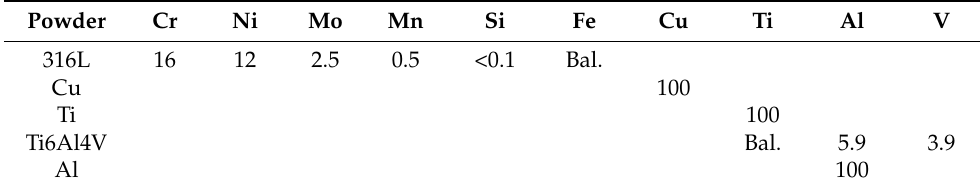
Table 1. Feedstock powders chemical composition (wt.%).